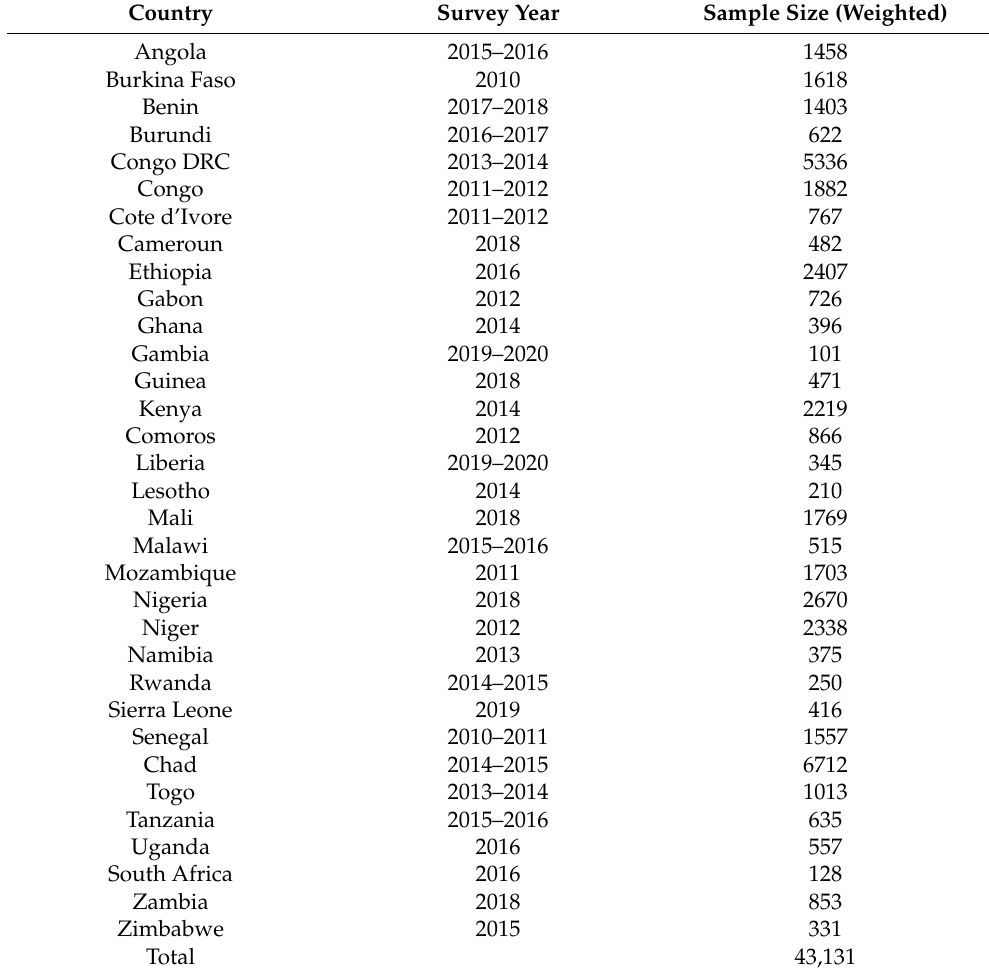
Table 1. Summary of eligible SSA countries and the DHS survey features. Country Survey Year Sample Size